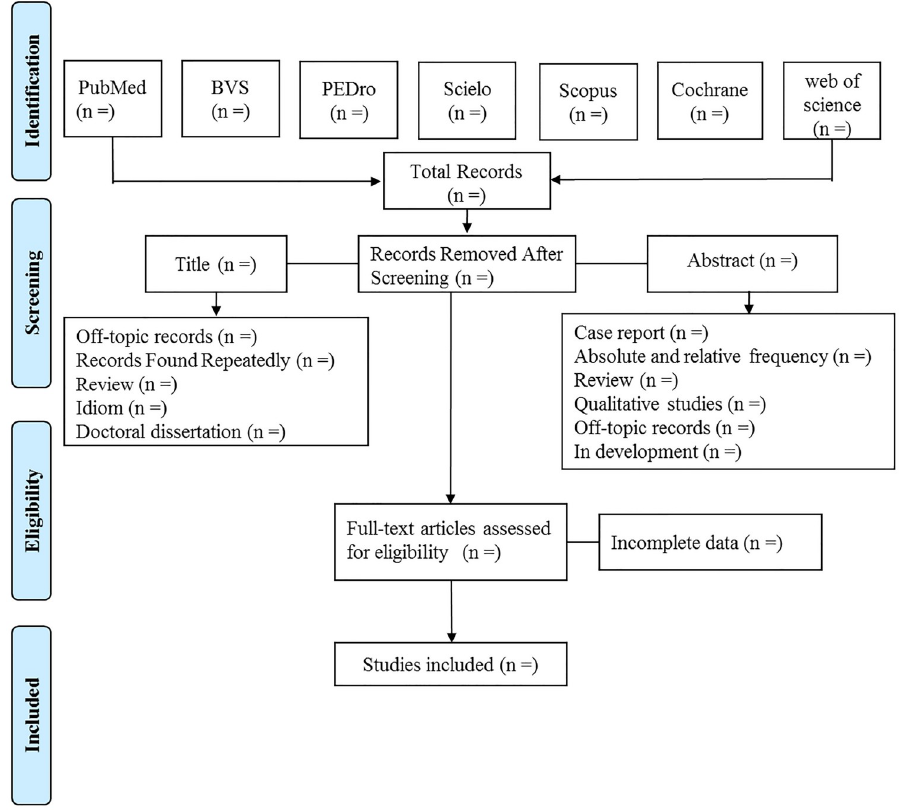
Fig 1. Study selection for review.